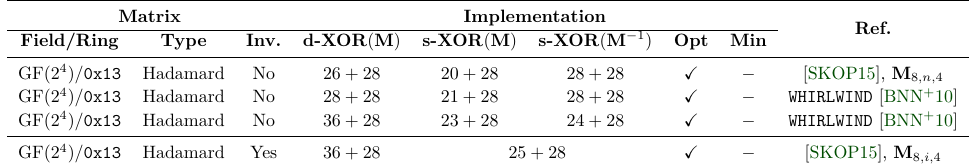
Table 4: Comparison of 8 × 8 MDS matrices Over GF(2 4